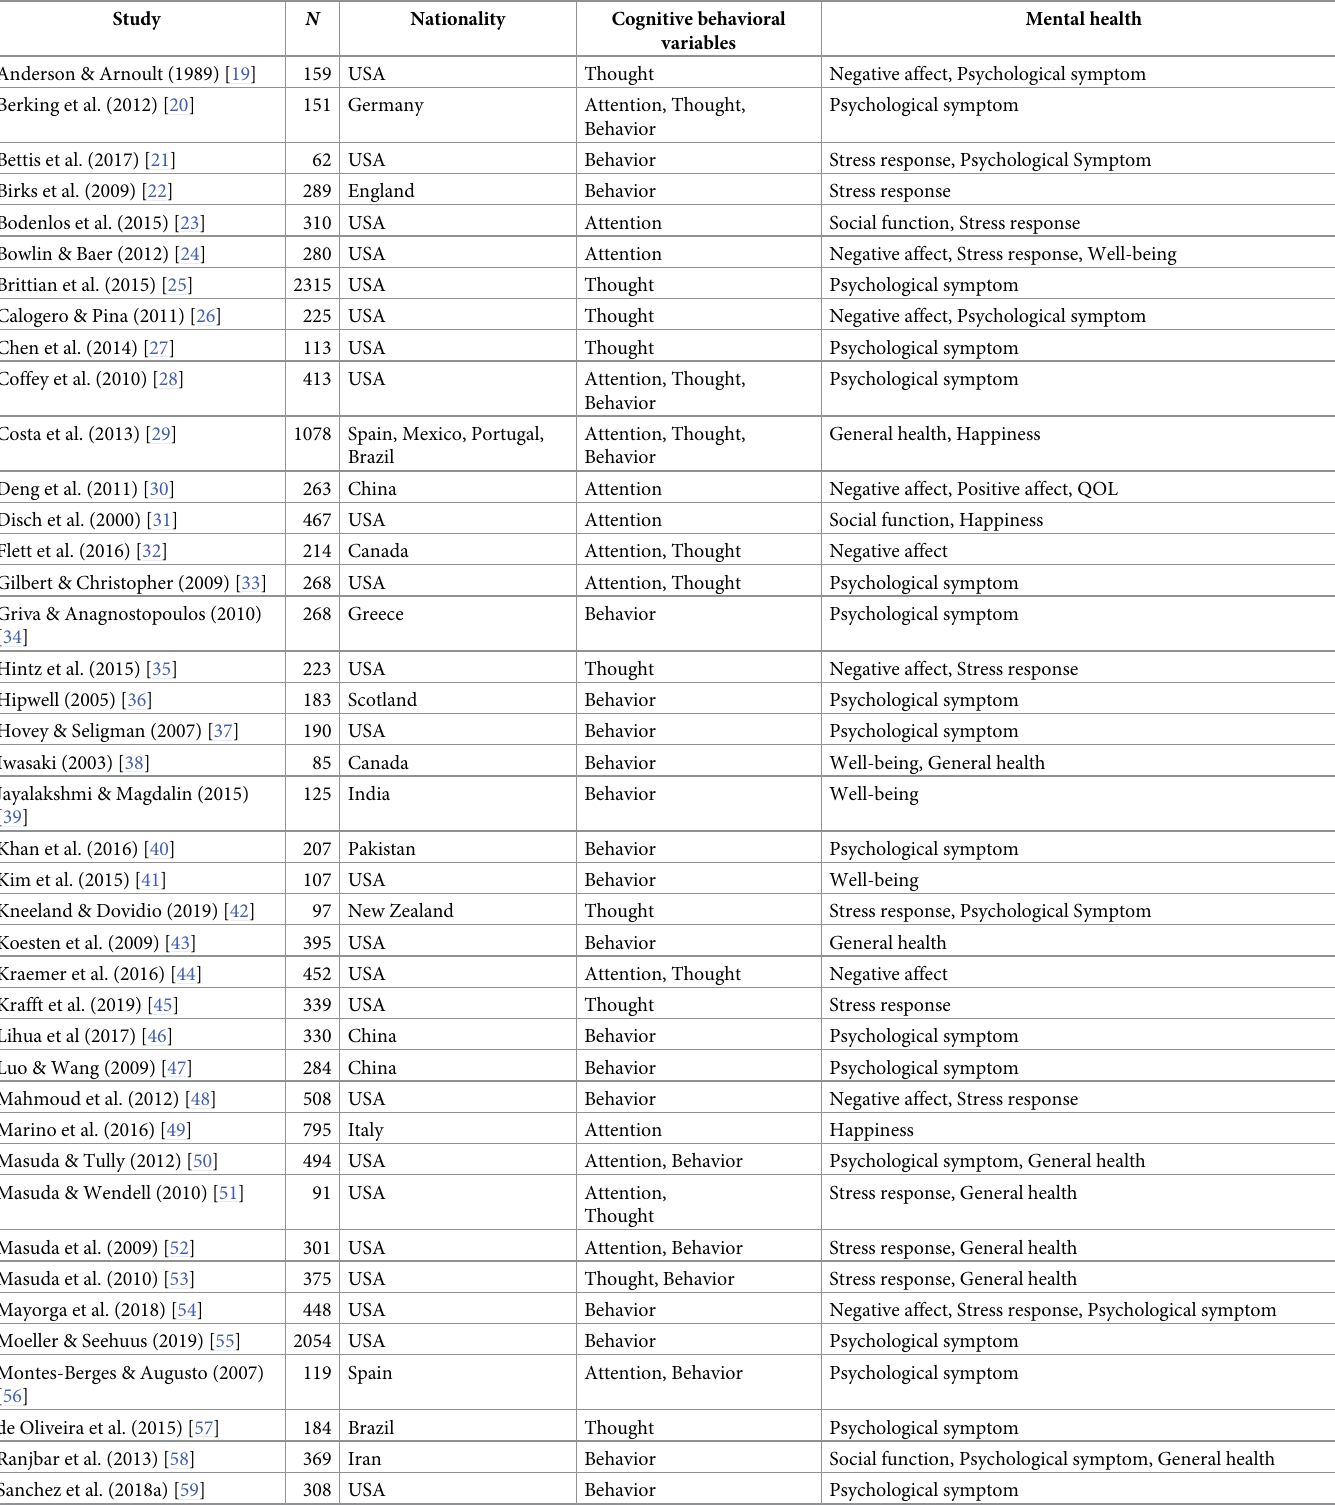
Table 1. Characteristics of the included